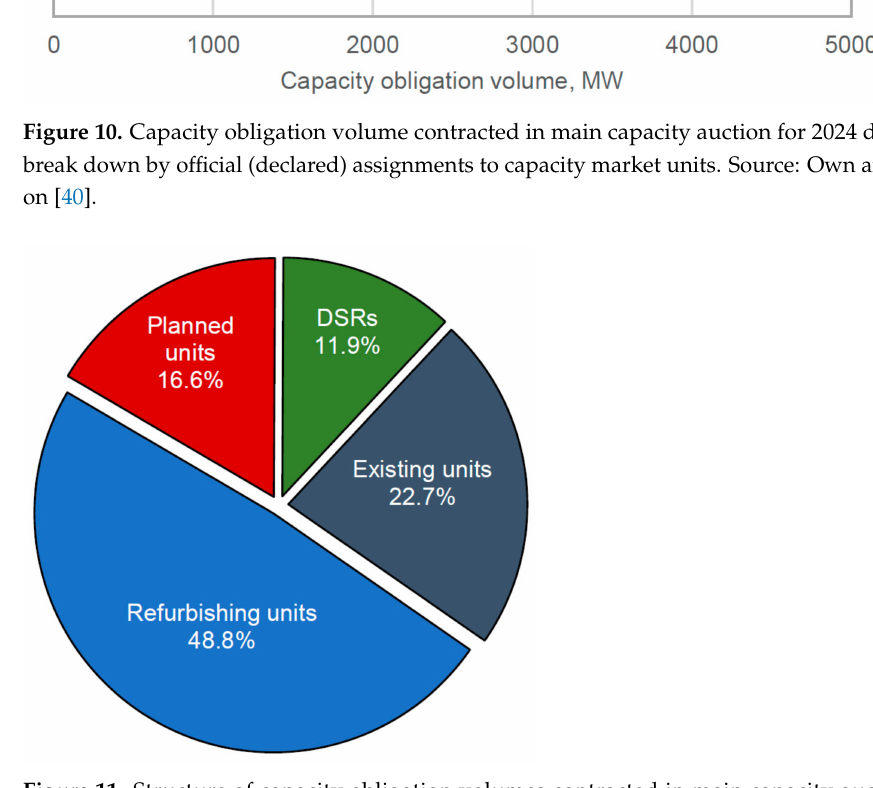
Figure 11. Structure of capacity obligation volumes contracted in main capacity auction for 2024 delivery year–break down by official (declared) assignments to capacity market units. Source: Own analysis based on